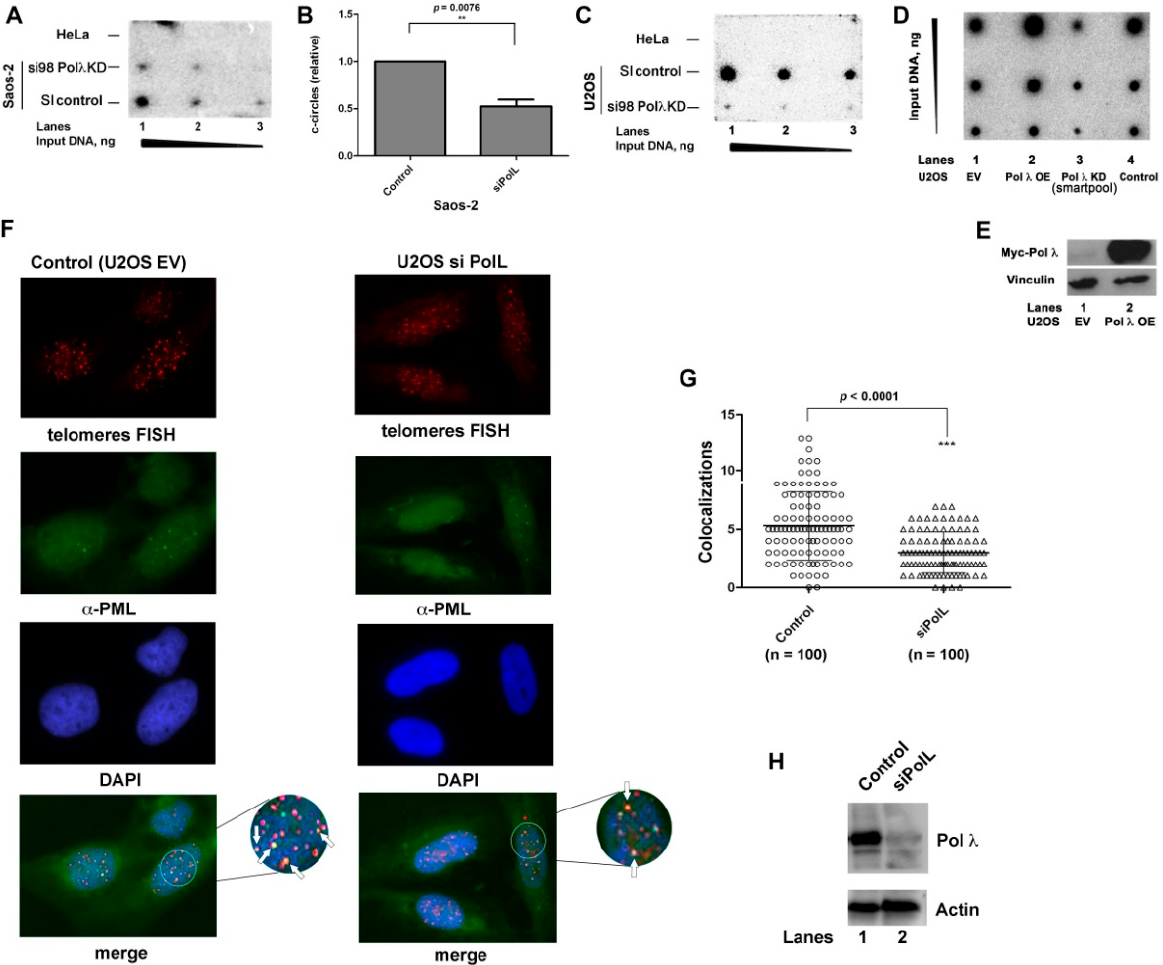
Figure 2. The levels of DNA polymerase λ correlate with the cellular ALT activity. ( A ) Dot blot assay for c ‐ circle formation. Different amounts of amplified c ‐ circle DNA from HeLa (top lane) or Saos ‐ 2 cells, either silenced for Pol λ (mid lane) or treated with scrambled control (bottom lane), were spotted on a membrane and hybridized with a radioactive telomeric probe. ( B ) Quantification of c ‐ circles in SI control vs. Pol λ KD Saos ‐ 2 cells. Values are the mean of three independent experiments, each comprising three different amounts of DNA as in panel A. Error bars are ± S.D. The χ 2 p value is shown on top. **, χ 2 p value <0.01. ( C ) As in panel A, but with c ‐ circle DNA amplified from HeLa cells (top lane) or U2OS cells, either silenced for Pol λ (bottom lane) or treated with scrambled control (mid lane). ( D ) Dot blot assay for c ‐ circle formation. Different amounts of am ‐ plified c ‐ circle DNA from U2OS cells transfected with the empty vector (EV, lane 1), U2OS cells overexpressing Pol λ (OE, lane 2), U2OS cells silenced for Pol λ (KD, lane 3) or untreated U2OS cells (Control, lane 4), were spotted on a membrane and hy ‐ bridized with a radioactive telomeric probe. ( E ) Western Blot analysis showing the levels of Pol λ in U2OS cells transfected with the Pol λ expression vector (corresponding to Pol λ OE of panel C). EV, U2OS cells transfected with the empty vector as negative control. ( F ) Confocal microscopy imaging of colocalization of PML protein (green) and telomeres (red) in U2OS cells either silenced for Pol λ (right panels) or control (left panels). Nuclei were stained with DAPI (blue). Representative colocalization events are indicated by white arrows. ( G ) Statistical analysis of three independent experiments comparing the number of colo ‐ calization events in control and silenced cells (n. of cells = 100 for each condition). The number of colocalization events observed within a single cell is shown for control (circles) and silenced (triangles) cells. χ 2 p value is shown on top (***, χ 2 p value < 0.0001). ( H ) Western Blot analysis showing the levels of Pol λ in U2OS cells either transfected with scramble control siRNA (lane 1) or anti ‐ Pol λ siRNA (lane 2). In order to investigate whether the ALT activity was directly dependent on Pol λ levels, the amount of c ‐ circles was next compared between U2OS cells wild type and either silenced for Pol λ or overexpressing ectopic c ‐ Myc Pol λ . As expected, silencing of Pol λ reduced c ‐ circles formation with respect to wild type cells (Figure 2D, compare lane 3 with